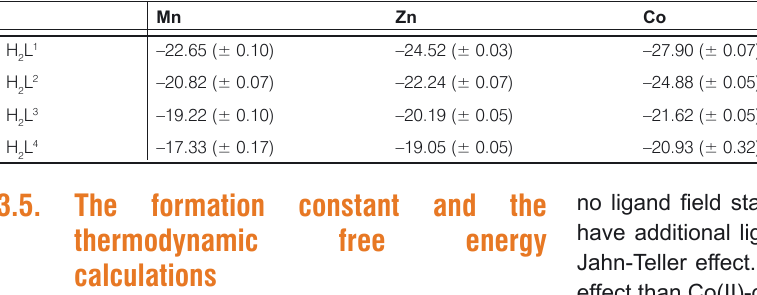
Table 6. The free energy, Δ G˚, for the complexes of ligands with M(II), in methanol at 25˚C (I = 0.10 mol dm -3